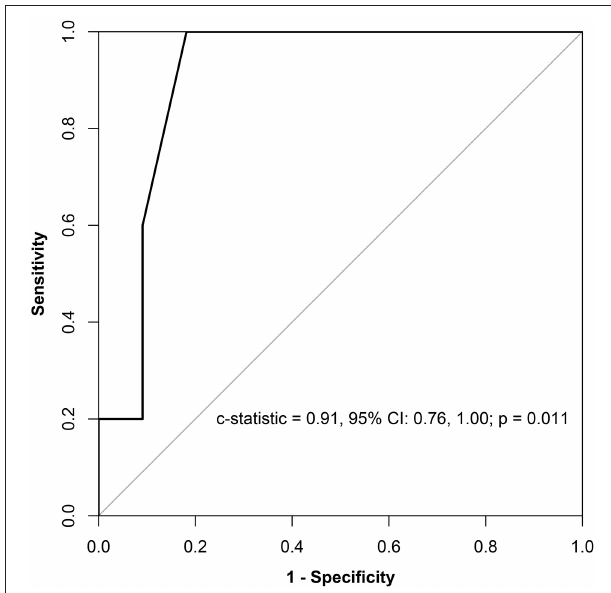
FIGURE 4 | Prognostic sensitivity and specificity of LVEDD for AF recurrence. LVEDD, left ventricular end-diastolic dimension; CI, confidential interval; AF, atrial